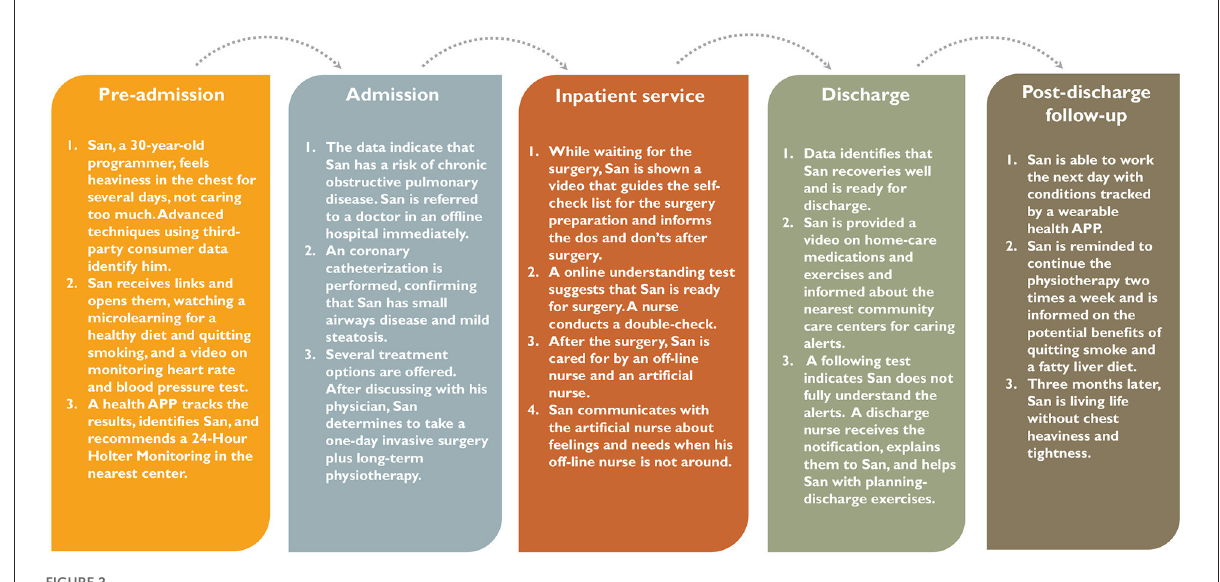
FIGURE2 An example of patient experience under data-driven integrated care